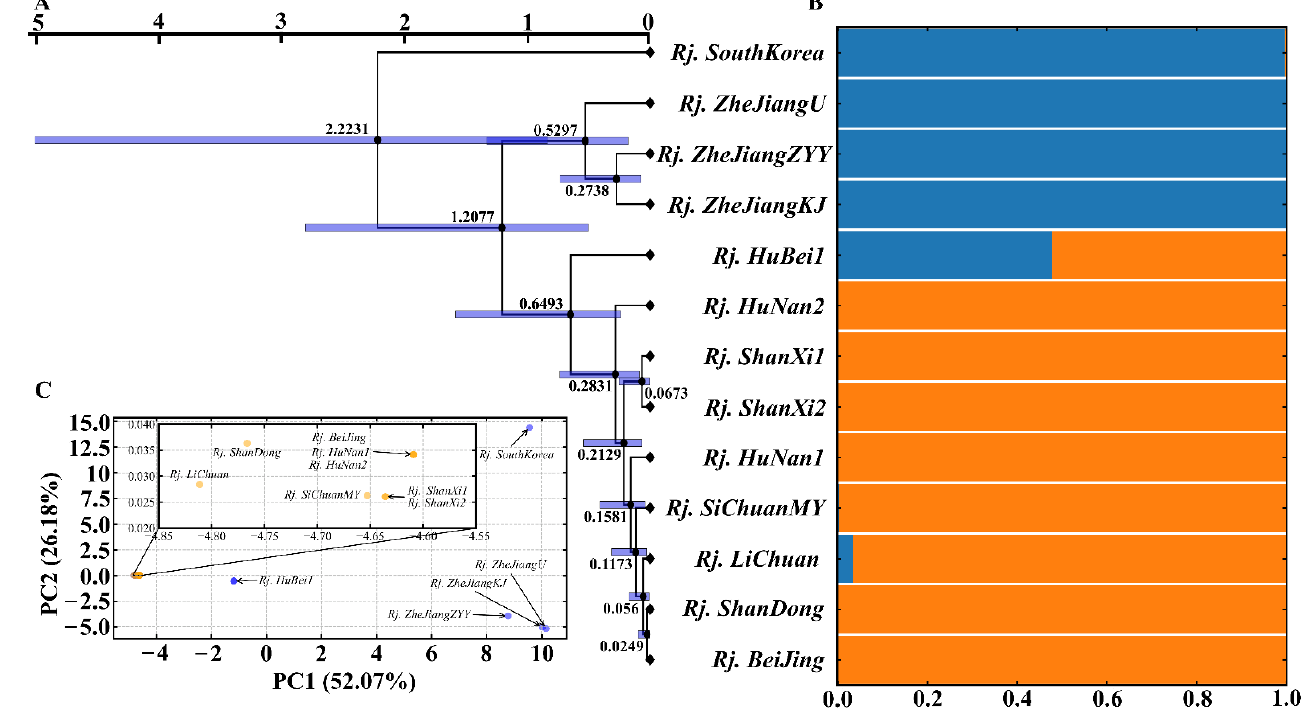
Figure 7. Intraspecific diversity and genetic structure of R. japonica based on whole chloroplast genomes: ( A ) phylogenetic tree; ( B ) population structure analysis with K = 2; ( C ) principal component analysis.